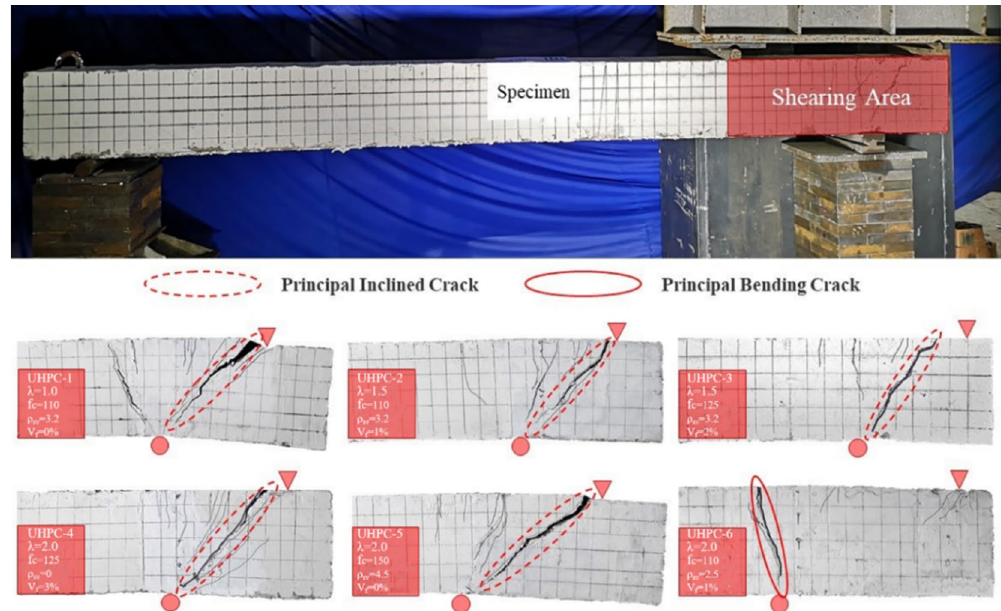
Figure 4. Failure mode of a